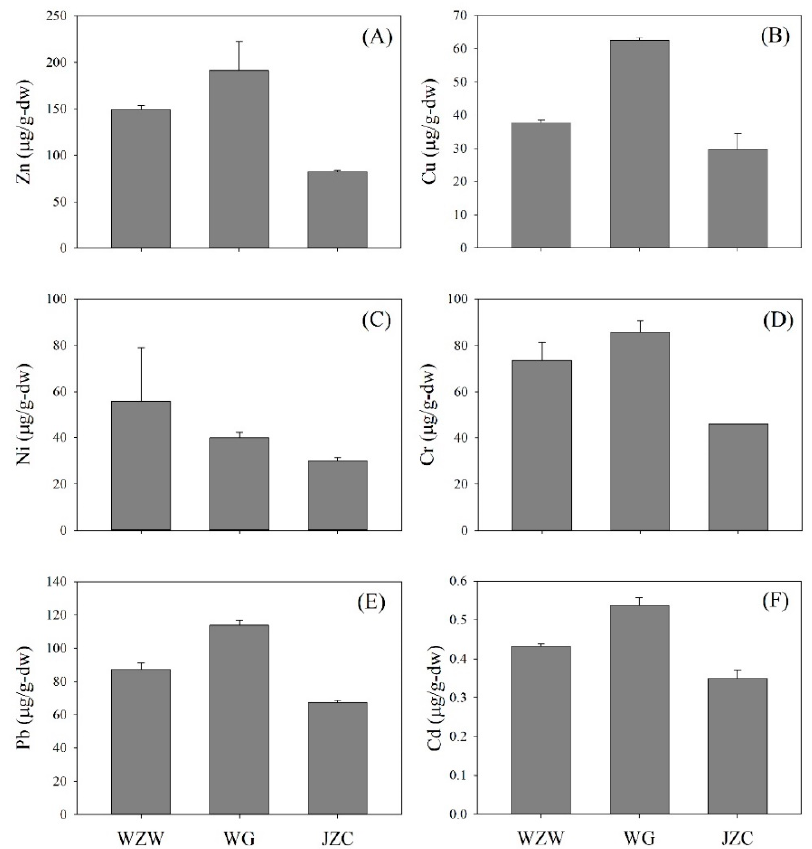
Figure 2. Metallic concentrations (mean ± SD) of ( A ) Zn, ( B ) Cu, ( C ) Ni, ( D ) Cr, ( E ) Pb, ( F ) Cd in surface sediment of the studied Danshuei Riverine Mangrove measured during the study period.